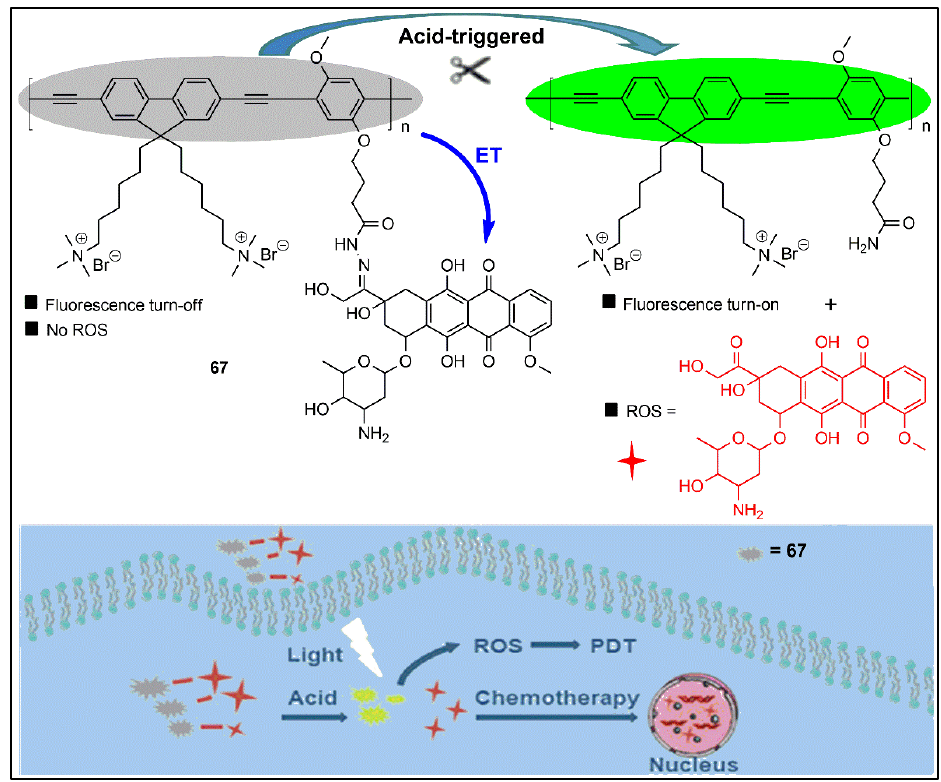
Figure 63. Schematic diagram of pH-responsive drug release and the mechanism of synergistic chemo-/PDT antitumor therapy. Adapted with permission from [173]. Copyright (2023) MDPI. The anticancer hydrophobic drug doxorubicin (DOX), is covalently attached to the side chain of the water-soluble polymer poly(fluorene-co-ethynylene) (PFE) via the acid- sensitive acylhydrazone bond in conjugate 67 . The fluorescence of the conjugated PEE is effectively quenched by the energy/electron transfer (ET) between DOX and the